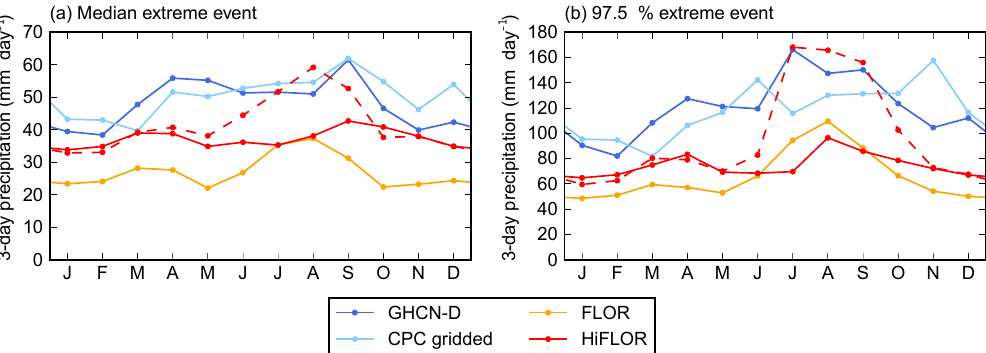
Figure 7. Annual cycle of monthly and spatial maximum 3-day averaged precipitation for point station data (GHCN-D, dark blue line), gridded observational data (CPC, light blue line) and model simulations (FLOR-FA, orange line, and HiFLOR, red lines). For HiFLOR, the 1990 static forcing experiment (solid red line) and the variable forcing SST-restored experiment (dashed red line) are included. Shown are (a) the median value of the monthly extremes and (b) the 97.5 percentile.